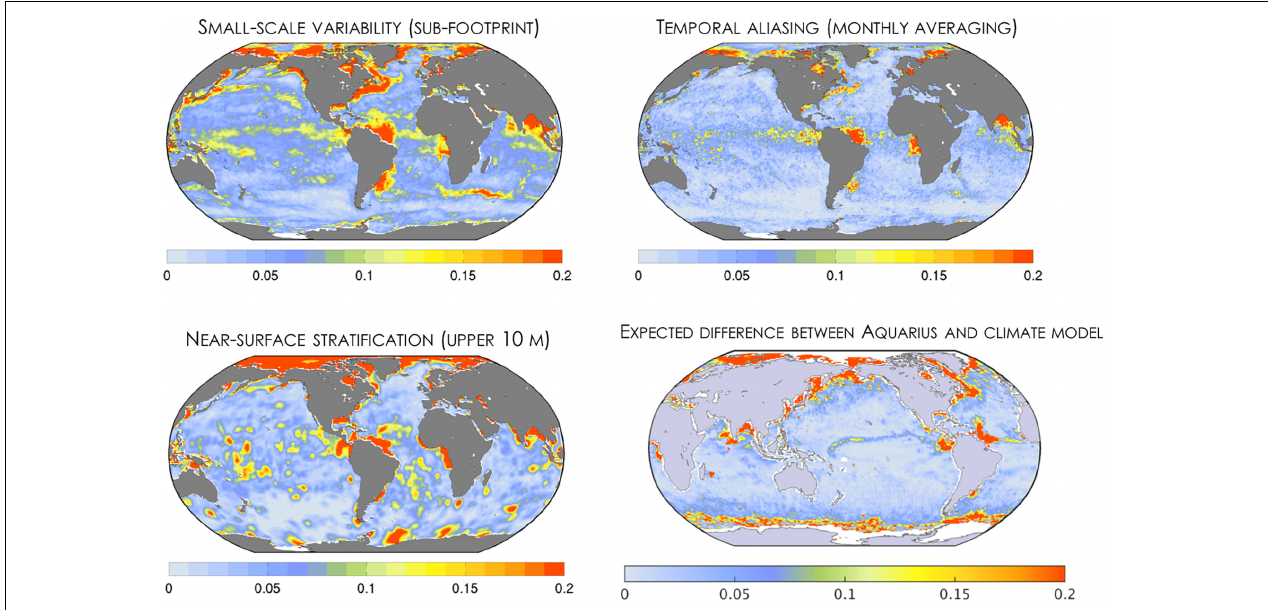
FIGURE 11 | Example of potential sampling errors associated with small-scale (sub-footprint) variability, temporal aliasing of satellite monthly fields, and salinity near-surface stratification in the upper ten meters. Total expected difference (as data error variance, in units pss 2 ) for the Aquarius SSS and a climate model. While small in the open ocean, sampling errors can be large in coastal regions and should be taken into account (removed) when estimating pure observational error for satellite salinity, as well as when reconciling (assimilating) it with other information. For example, such a correction can reach 0.7 pss near the Amazon, 0.5 pss in the Gulf Stream, and 0.4 pss in the Bay of Bengal. For details, see Vinogradova and Ponte (2012, 2013b) and Vinogradova et al.